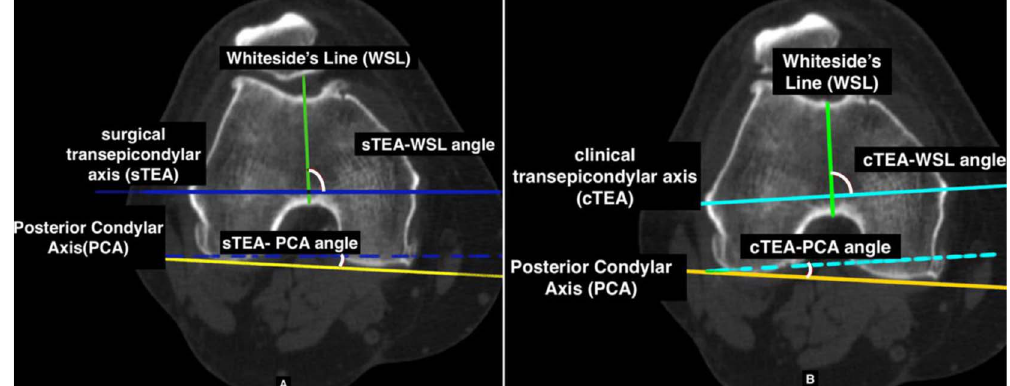
Figure 1. Angles measured on the distal femur in relation to (a) sTEA and (b)